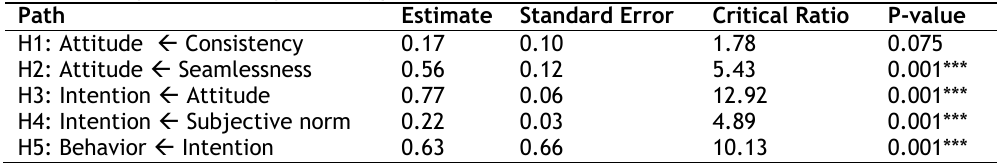
Table 2. Regression weights of